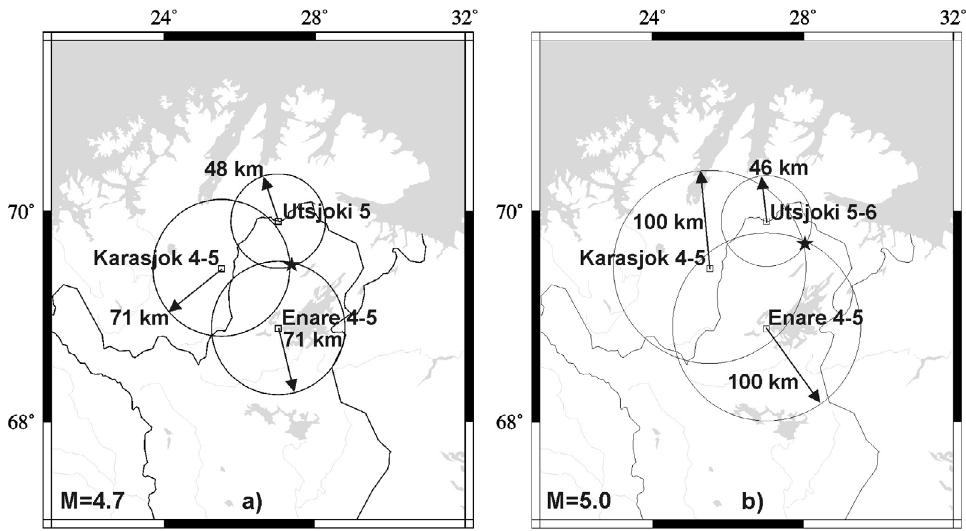
Figure 5. Stars denote possible epicenters for the earthquake of December 31, 1758 when magnitudes are assumed to be 4.7 (a) and 5.0 (b). Intensities at Utsjoki, Karasjok and Enare were assessed according to Wegelius